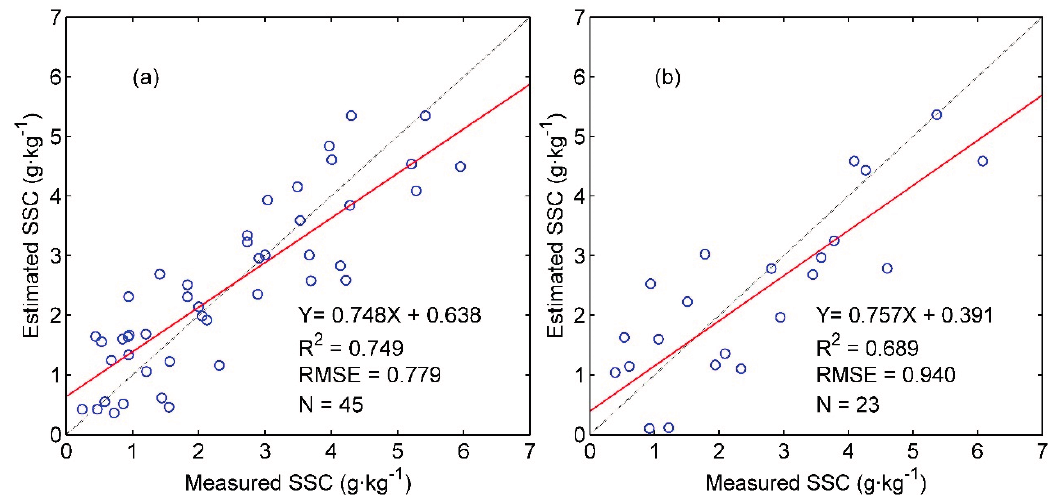
Figure 5. Comparison of measured and modelled soil salinity with modelling samples ( a ) and validation samples ( b ). The horizontal axis denotes measured soil salinity, and the vertical axis denotes modelled soil salinity. Slope and intercept, R 2 , RMSE and sample numbers are provided for the comparison. Table 5. Performance assessment of the PLSR model. The statistics describes model performance for modelling samples, validation samples and total samples (modelling + validation), including R 2 , bias, SD (standard deviation), RMSE (root mean square error), ratio of prediction to deviation (RPD), number of samples (N), slope ( a ) and intercept ( b ). Linear Regression Samples R 2 RPD Bias SD RMSE N a b Modelling 0.749 3.584 0.036 0.778 0.779 45 0.748 0.638 Validation 0.689 2.838 0.724